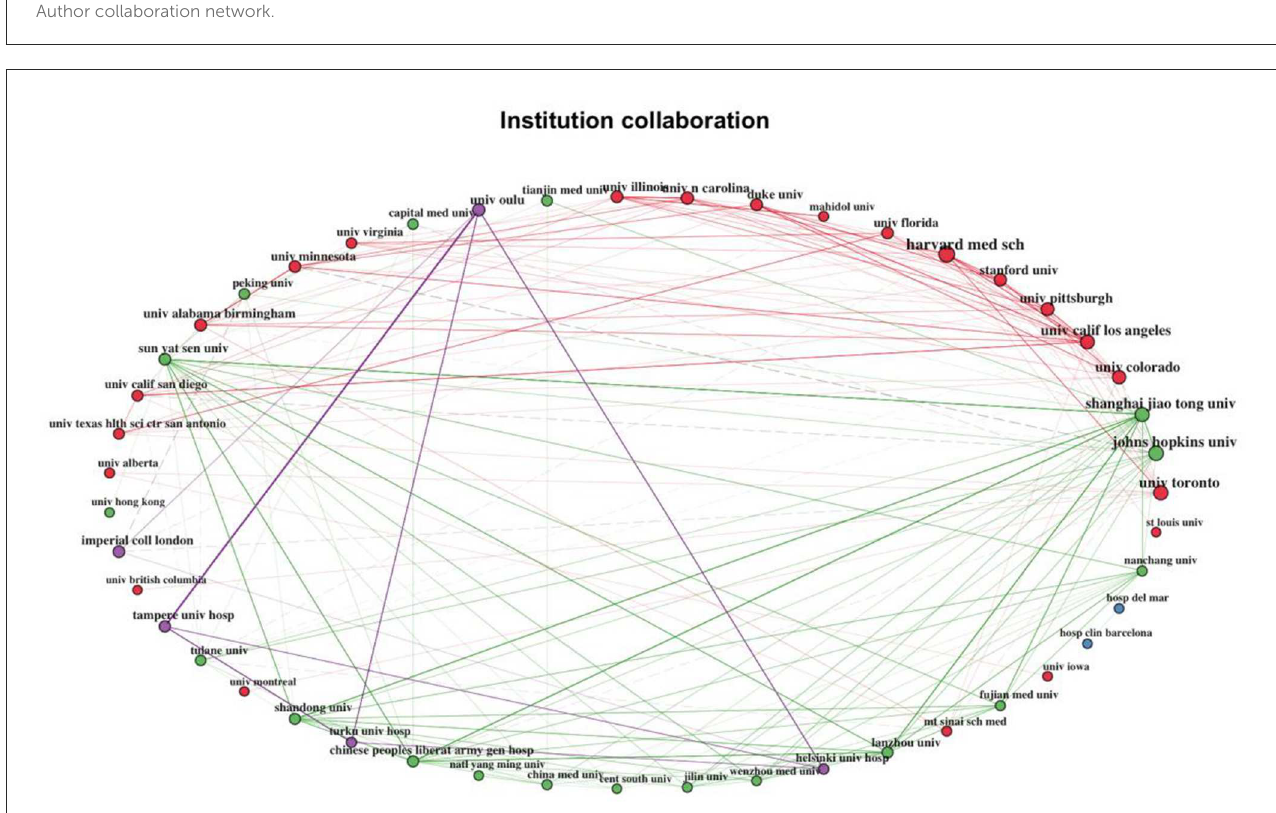
FIGURE11 Institution collaboration network.